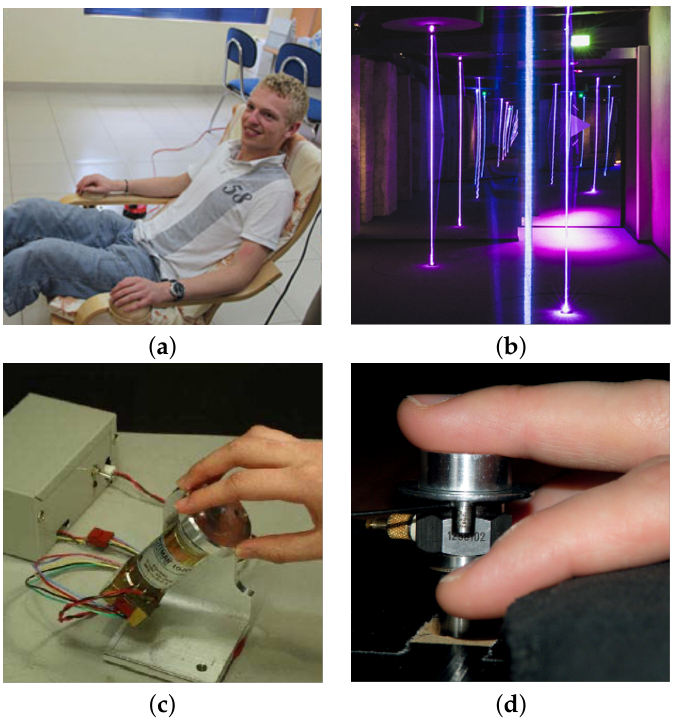
Figure 3. Examples of haptic player installations (HMPIs): ( a ) Deaf user experiencing music in a haptic chair, retrieved from in [8]. ( b ) Multimodal platform, retrieved from in [49]. ( c ) Desktop haptic knob installation, retrieved from in [50]. ( d ) Desktop haptic button installation, retrieved from in